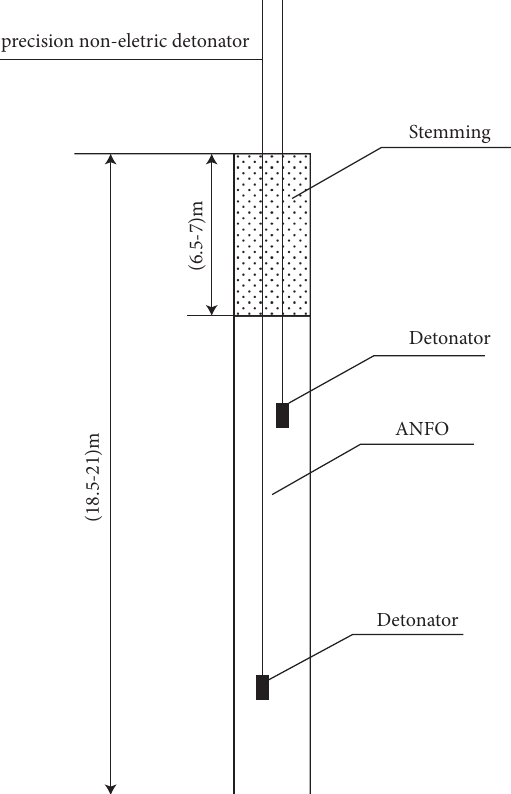
Figure 4: Structure of the filled